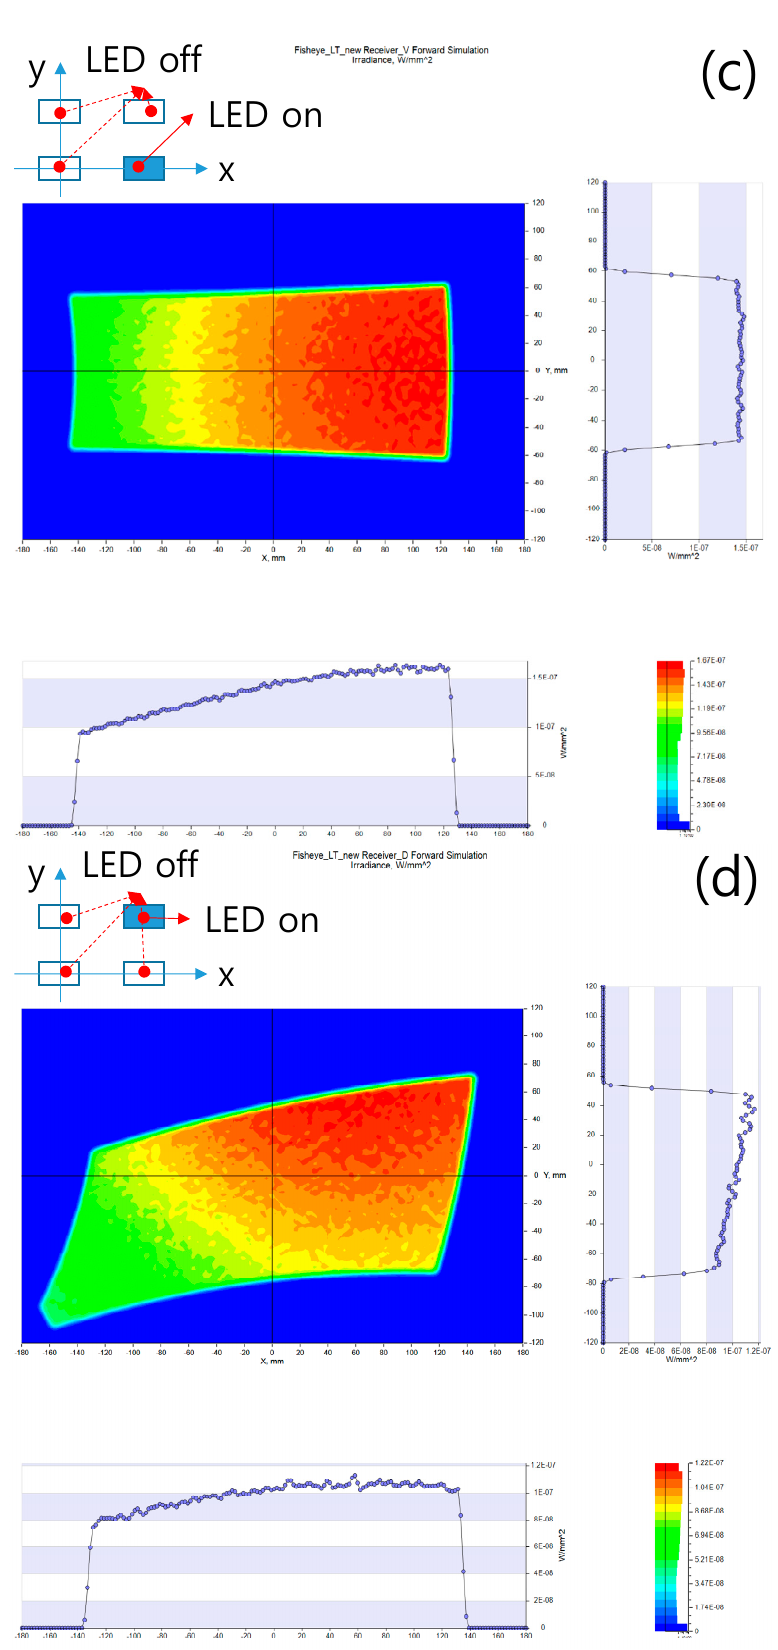
Figure 6. Intensity distributions on the targets obtained using the fisheye lens system. The light illumination profiles when LED light was placed in the ( a ) center, ( b ) horizontal, ( c ) vertical, and ( d ) diagonal positions.